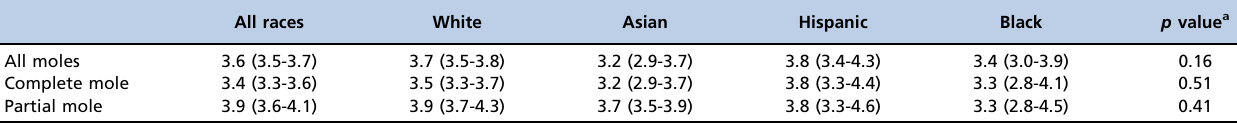
Table S4 - Comparison of hCG half-lives by race/ethnicity among women with hydatidiform molar pregnancies, adjusted for age, with 95% Confidence Intervals. All races White Asian Hispanic Black p value a All